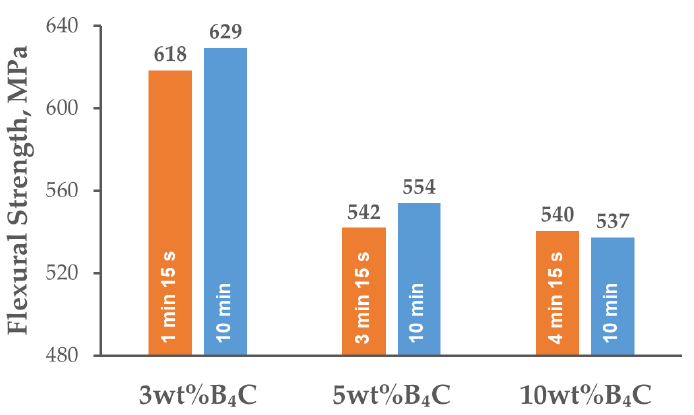
Figure 7. Brinell hardness of AA7075-B 4 C composites spark plasma sintered at various holding times.